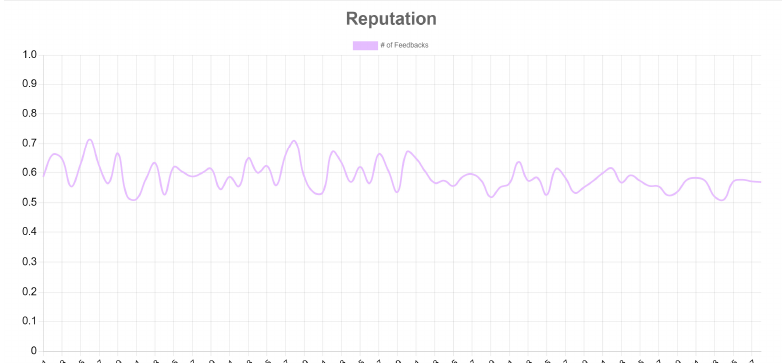
Figure 5. Reputation Chart for SP2.